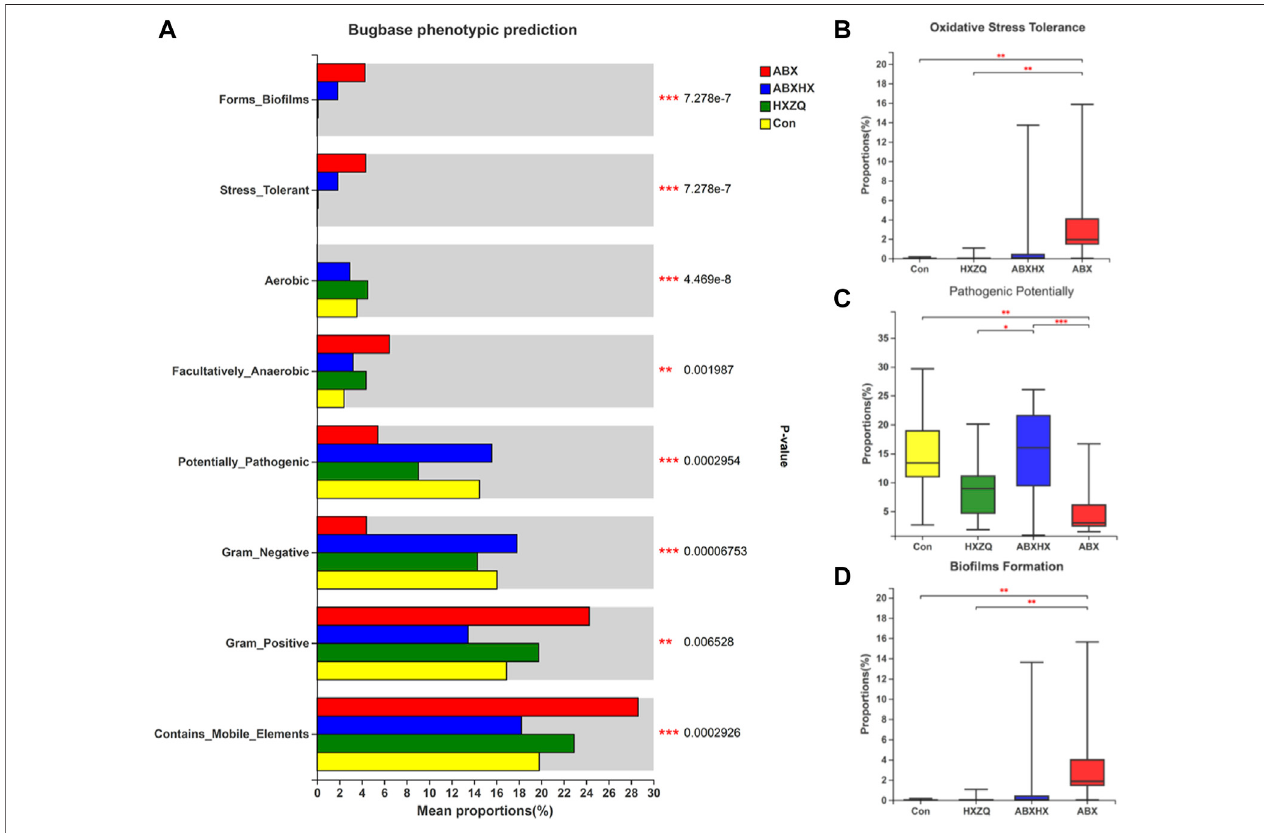
FIGURE 4 | Bugbase phenotypic prediction of gut microbiota in mice model. (A) Comparisons between four groups of all phenotypes. (B) Oxidative stress tolerance. (C) Pathogenic potentially. (D) Bio fi lm formation. Kruskal – Wallis H test was applied. * p -value < 0.05; ** p < 0.01; *** p < 0.001.